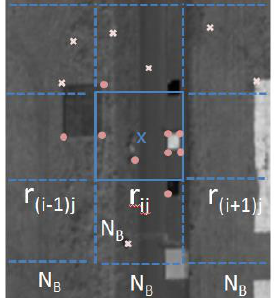
Figure 3. An illustration for the division of the image into blocks and selection of the closest N K = 9 points to the center of the block r ij . The solid circles indicate the closest points to the center of the block (shown with blue x), while the crosses correspond to other keypoints.